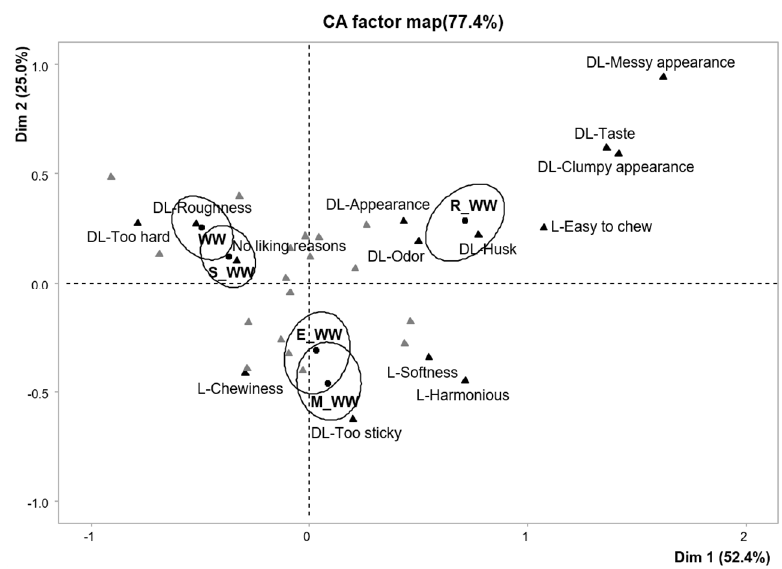
Figure 1. Correspondence analysis plot for reasons of (dis) liking attributes and their corresponding various processed whole wheat sample loadings. Filled circle shapes indicate the sample loadings and filled triangle point up shapes refer to the descriptors.